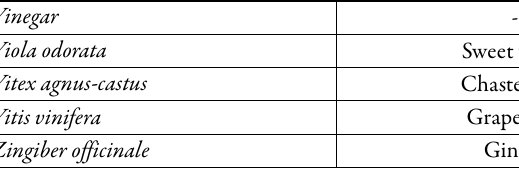
Table 13. Medicinal plants for the treatment of bloating on the basis of Avicenna’s book (Naseri et al